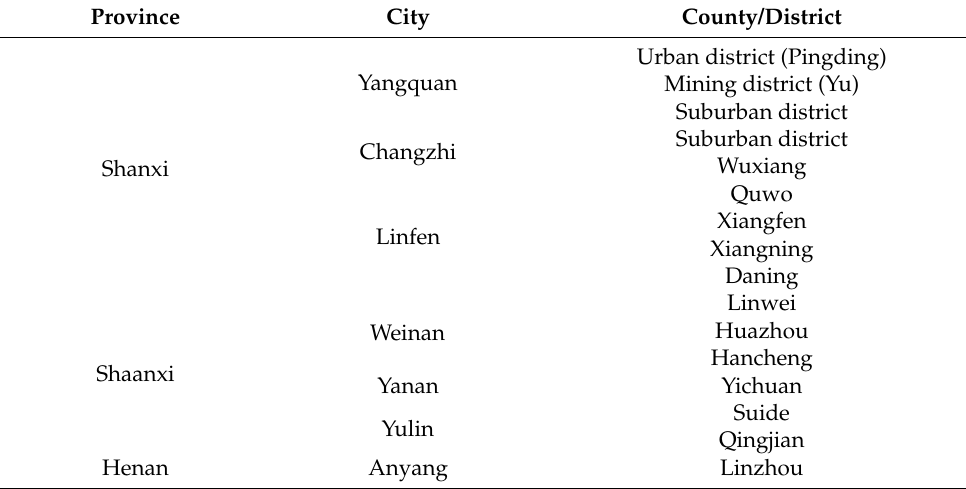
Table 2. Detailed information of endemic